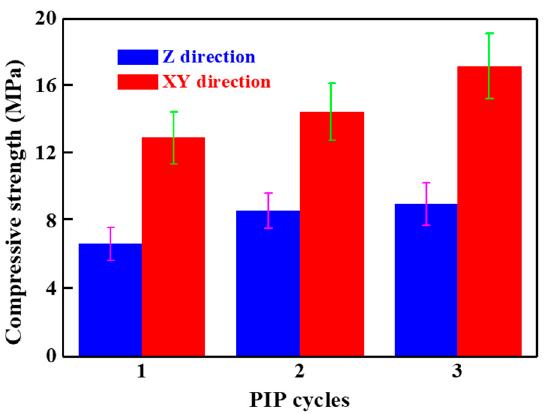
Figure 6. Compressive strengths of as-prepared composites with different PIP cycle numbers ranging from 1 to 3 times.